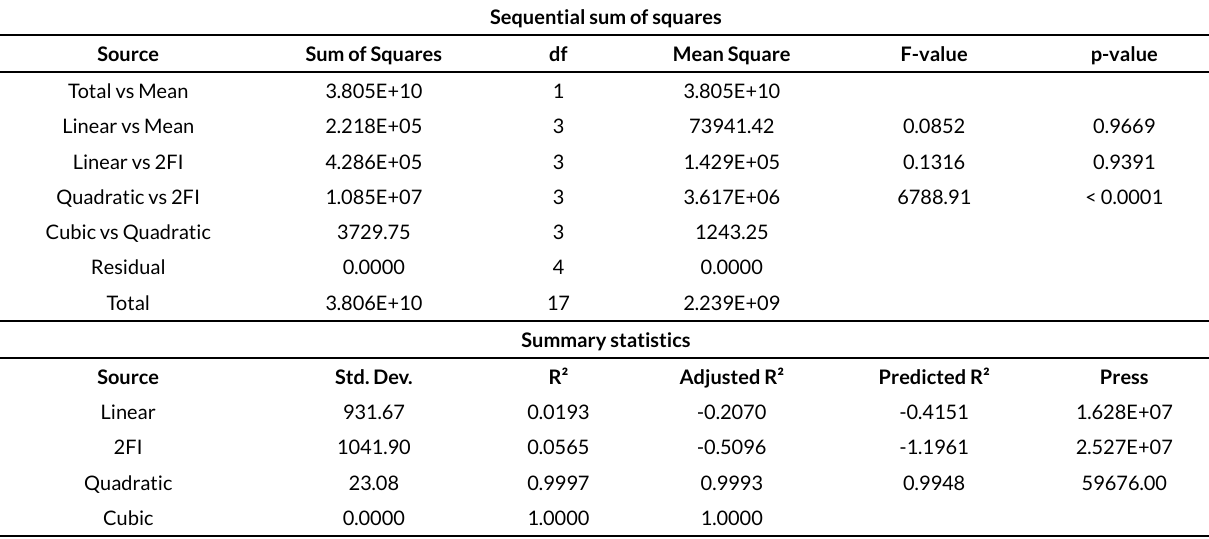
Table 3. The sequential fitting model with peak area as a response to quantify acetic acid content. Sequential sum of